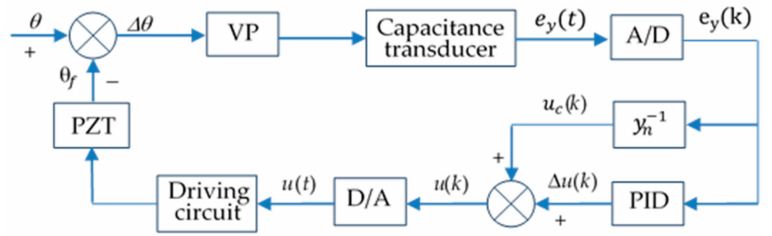
Figure 5. A block diagram of the PID feedback controller with hysteresis model compensation.